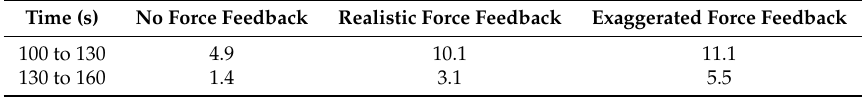
Table 7. % Maximum undershoot at different time intervals.